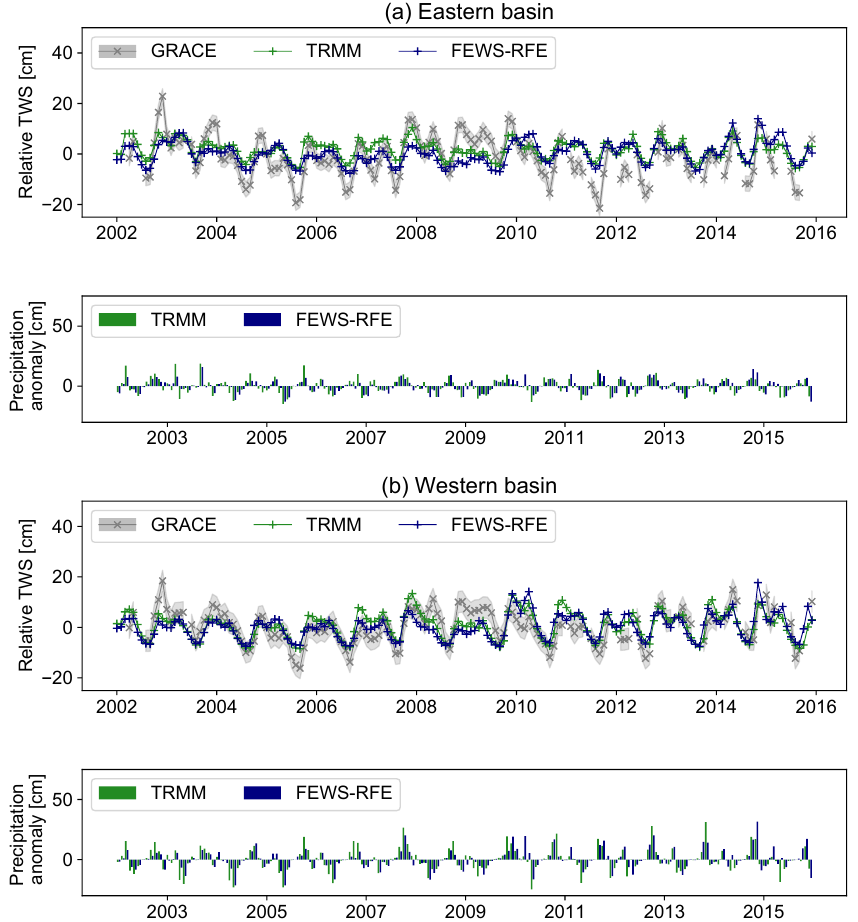
Figure 9. Total water storage change and precipitation anomaly referenced to the monthly climatology over the period of simulation for the eastern (a) and western (b)